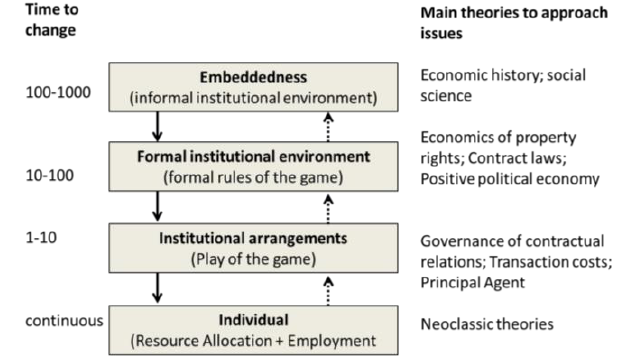
Figure 1 . Four Level Scheme (based on [9] (p.